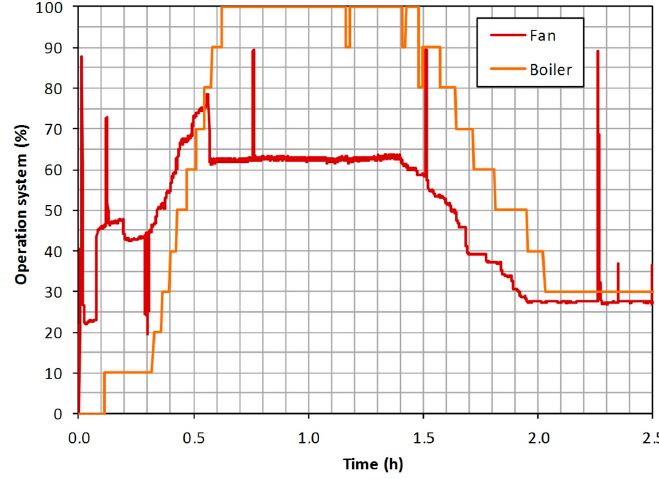
Figure 7. Boiler modulation during combustion test of pellets LAB2.